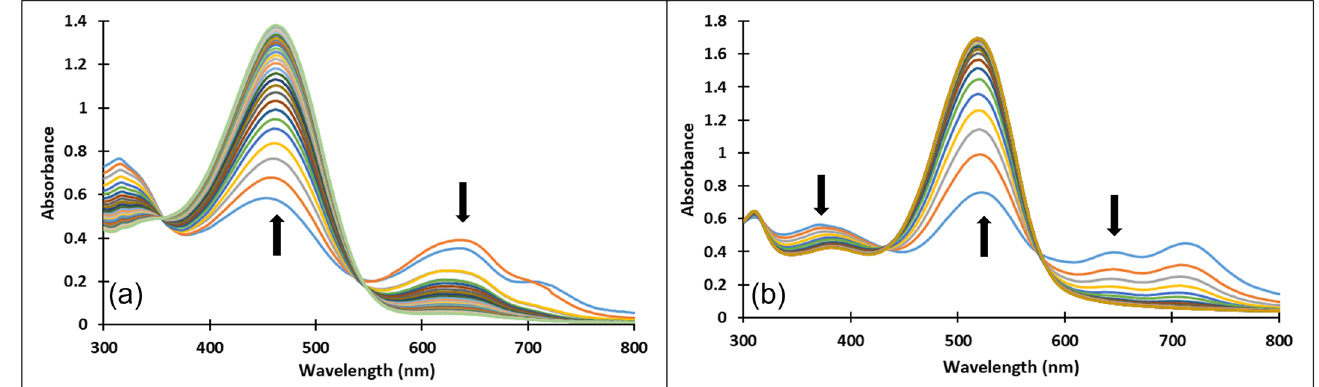
Figure 12. Spectral variations after direct pH-jumps of compound 4 solution, from ( a ) neutral to basic or ( b ) neutral to acidic pH values.